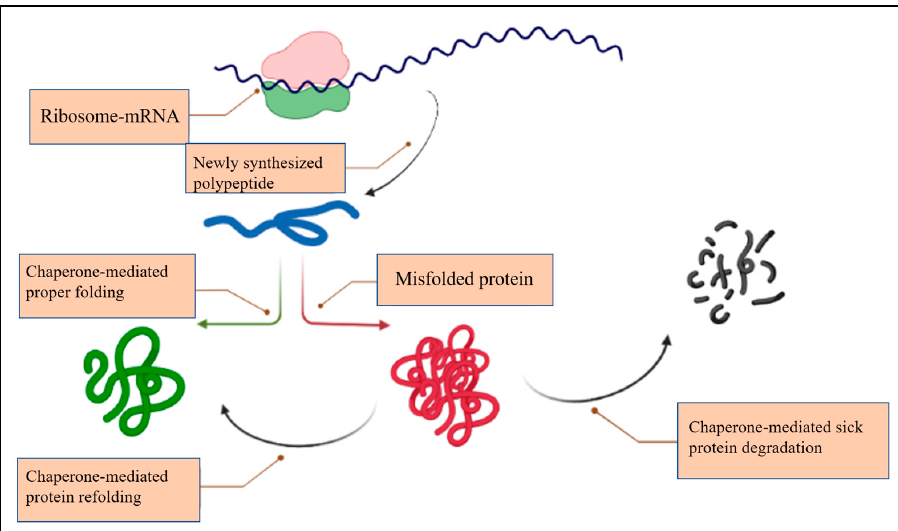
Figure 1. The role of chaperones in the protein-folding process.